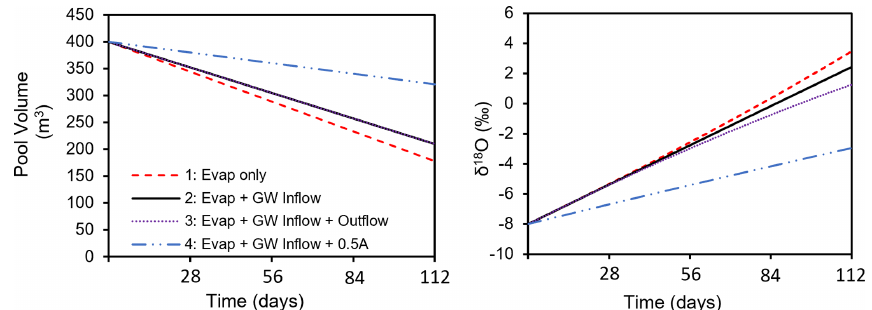
Figure 13. Evolution of pool volume and values of stable isotopes of water in pools with varying water balance components over approx- imately 4 months of dry season (evap: evapotranspiration, GW: groundwater, A : pool area). Model modified after Bourke et al. (2021) to simulate a pool instead of a flowing